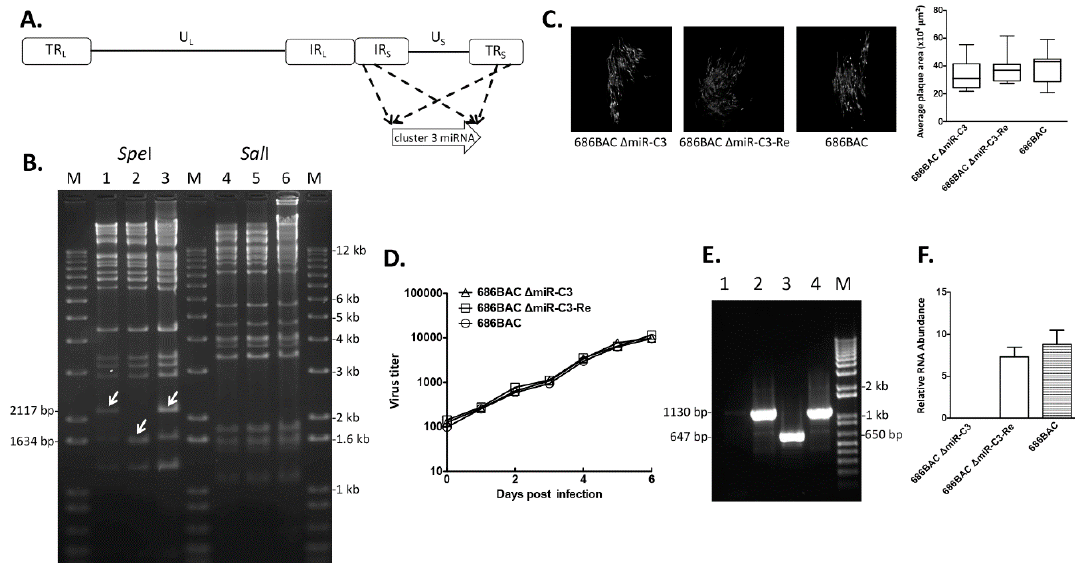
Figure 1. In vitro characterization of cluster 3 miRNA deletion and revertant viruses. ( A ) Marek’s disease virus (MDV) genome consists of unique long (U L ) and short (U S ) regions, each flanked by terminal and internal inverted repeat regions. Cluster 3 miRNAs are located within the internal (IR S ) and terminal (TR S ) repeat short regions of the MDV genome. ( B ) Restriction fragment length polymorphism (RFLP) analysis of bacterial artificial chromosome (BAC) DNA. Parental 686BAC (lanes 1 and 4), mutant 686BAC Δ miR-C3 (lanes 2 and 5), and revertant 686BAC Δ miR-C3-Re (lanes 3 and 6) DNA was digested with Spe I or Sal I. Arrows represent the DNA fragment in 686BAC Δ miR-C3 that is different from the parental and revertant BACs. M: 1 kb plus DNA ladder. ( C ) Plaque area measurement. Chicken embryonic fibroblasts (CEFs) were infected with the indicated virus. Six days later, infected CEFs were fixed and subjected to an immunofluorescence assay with MDV pp38 antibody and Fluorescein isothiocyanate (FITC)-conjugated secondary antibody. For each virus, plaques were imaged (left), and the average plaque area of 30 randomly selected plaques is measured in µm 2 (right). ( D ) In vitro growth kinetics. CEFs were infected with 100 plaque-forming units (PFUs) of parental 686BAC, mutant 686BAC Δ miR-C3, or revertant 686BAC Δ miR-C3-Re. At 1, 2, 3, 4, 5, and 6 days post-infection, infected cells were trypsinized, serially diluted, and seeded on fresh CEFs. Plaques were counted at 7 days post-infection and presented as virus titers. ( E ) PCR analysis of the MDV genome. Genomic DNA isolated from uninfected CEFs (lane 1) or parental 686BAC-infected (lane 2), mutant 686BAC Δ miR-C3-infected (Lane 3), or revertant 686BAC Δ miR-C3-Re-infected (Lane 4) CEFs were subjected PCR using cluster 3 miRNA flanking primers. M: 1 kb plus DNA ladder. ( F ) qPCR analysis of cluster 3 miRNA expression in vitro. Total RNA isolated from parental 686BAC-, mutant 686BAC Δ miR-C3-, or revertant 686BAC Δ miR-C3-Re-infected CEFs were subjected to complementary DNA (cDNA) synthesis, followed by qPCR analysis of cluster 3 miRNA expression. Cluster 3 miRNAs expression levels were normalized to viral genome levels and presented as relative RNA abundance.